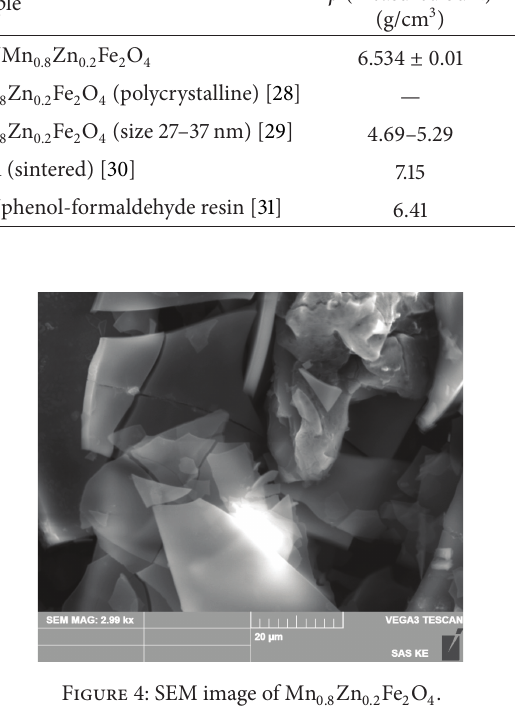
Table 1: The mechanical properties and electric resistivity of FeSi/Mn bulk density, transverse rupture strength (TRS), Young modulus ( 𝐸 ), mechanical hardness (HV), and specific electric resistivity. Sample